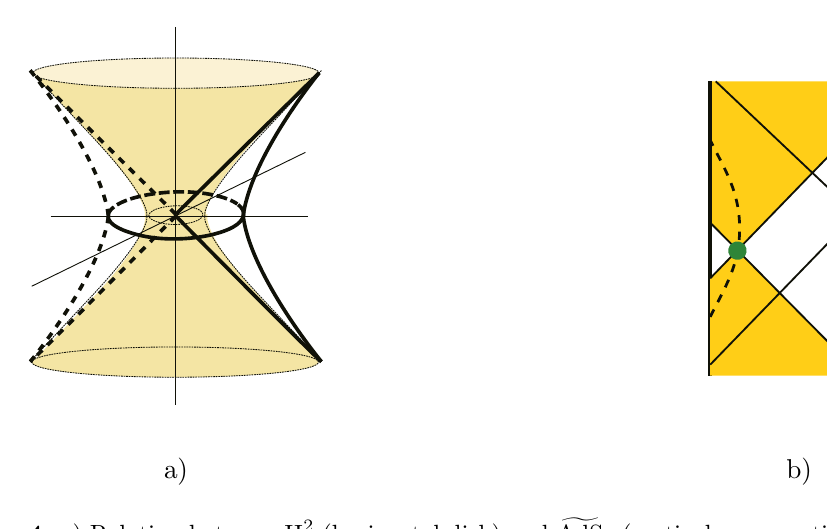
Figure 4 . a) Relation between H 2 (horizontal disk) and g AdS 2 (vertical cross section) embedded